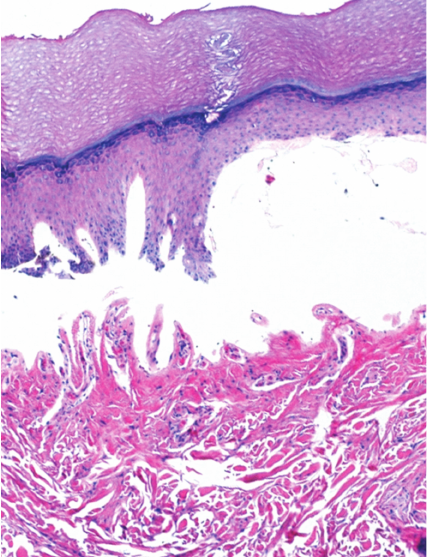
Figure 6: Porphyria cutanea tarda: subepidermal bulla and festoon- ing of the dermal papilla are prominent. There is no significant inflammatory infiltrate (hematoxylin-eosin, original magnification ×